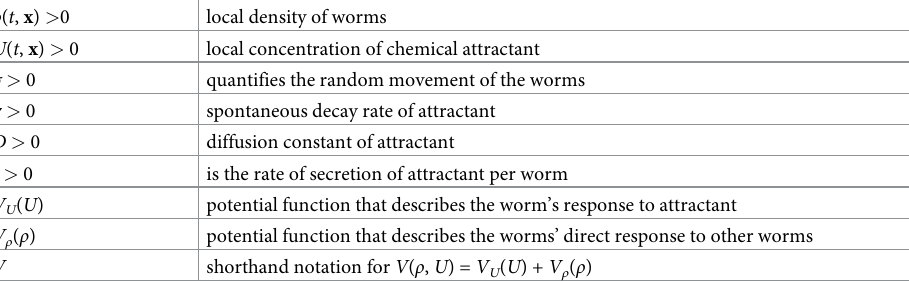
Table 1. Functions and parameters appearing in the